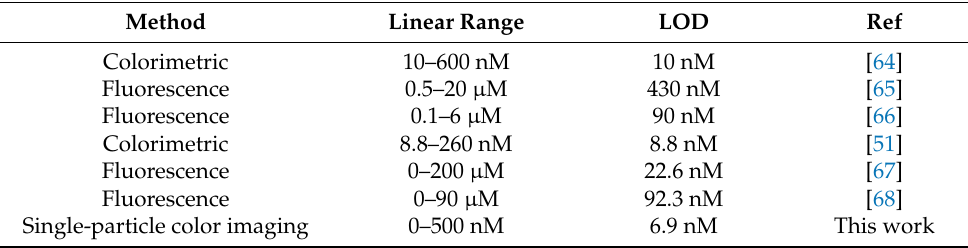
Table 1. Comparison of various iodide detection